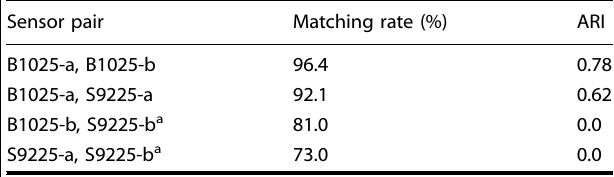
Table 1. Validity metrics for Experiment 1.